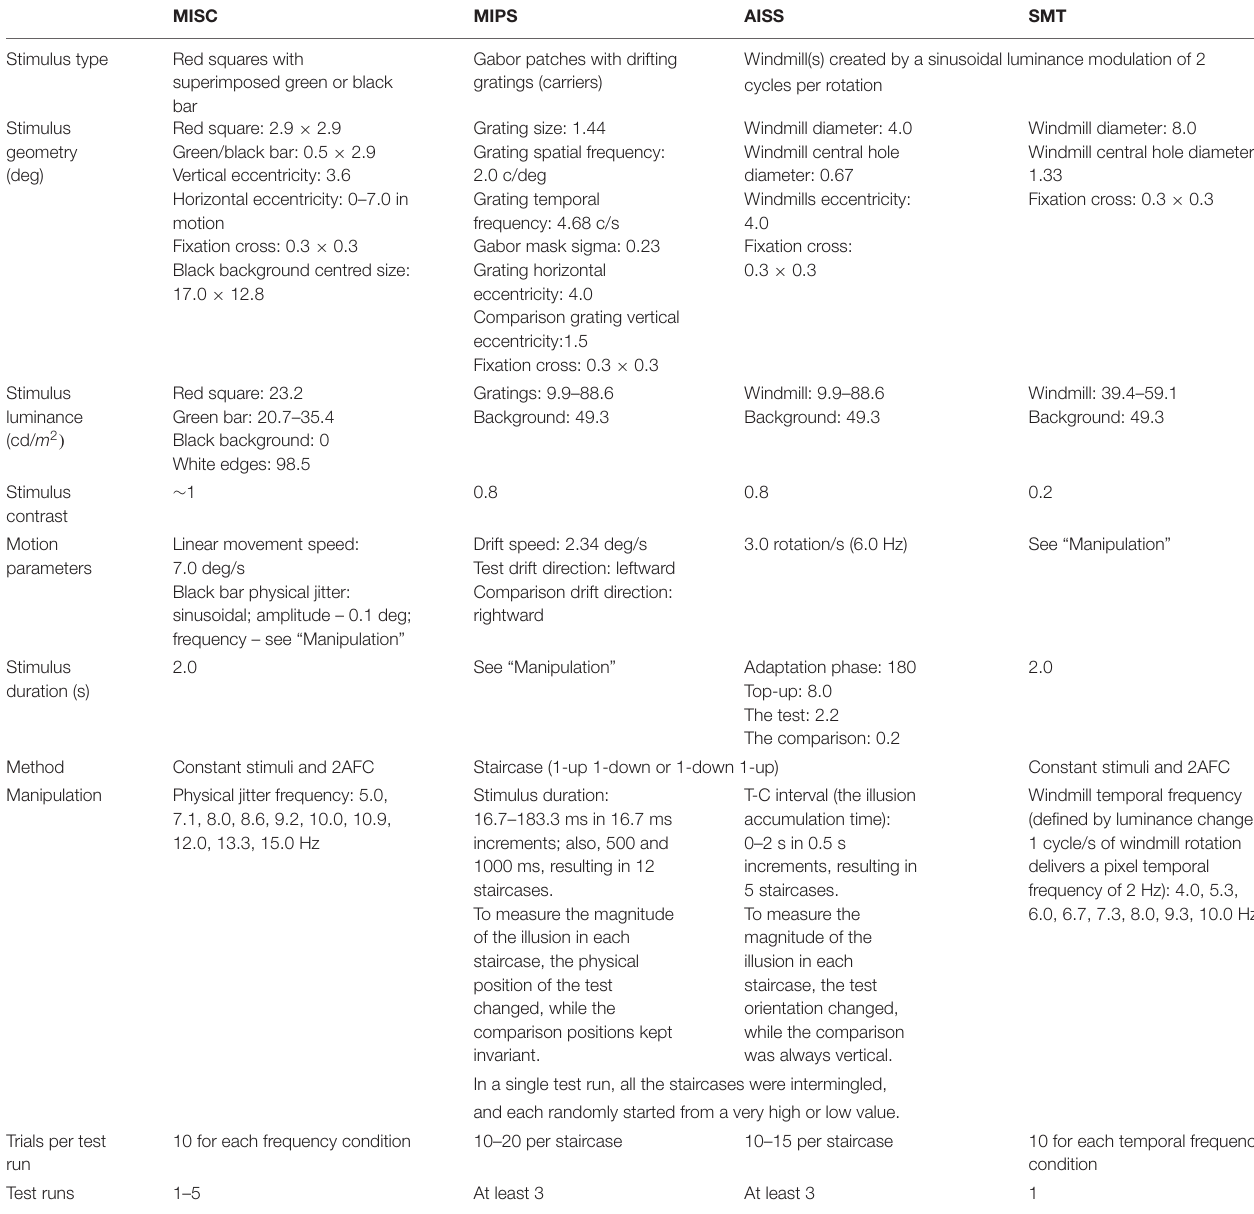
Gabor patches with drifting Windmill(s) created by a sinusoidal luminance modulation of 2 gratings (carriers) cycles per rotation